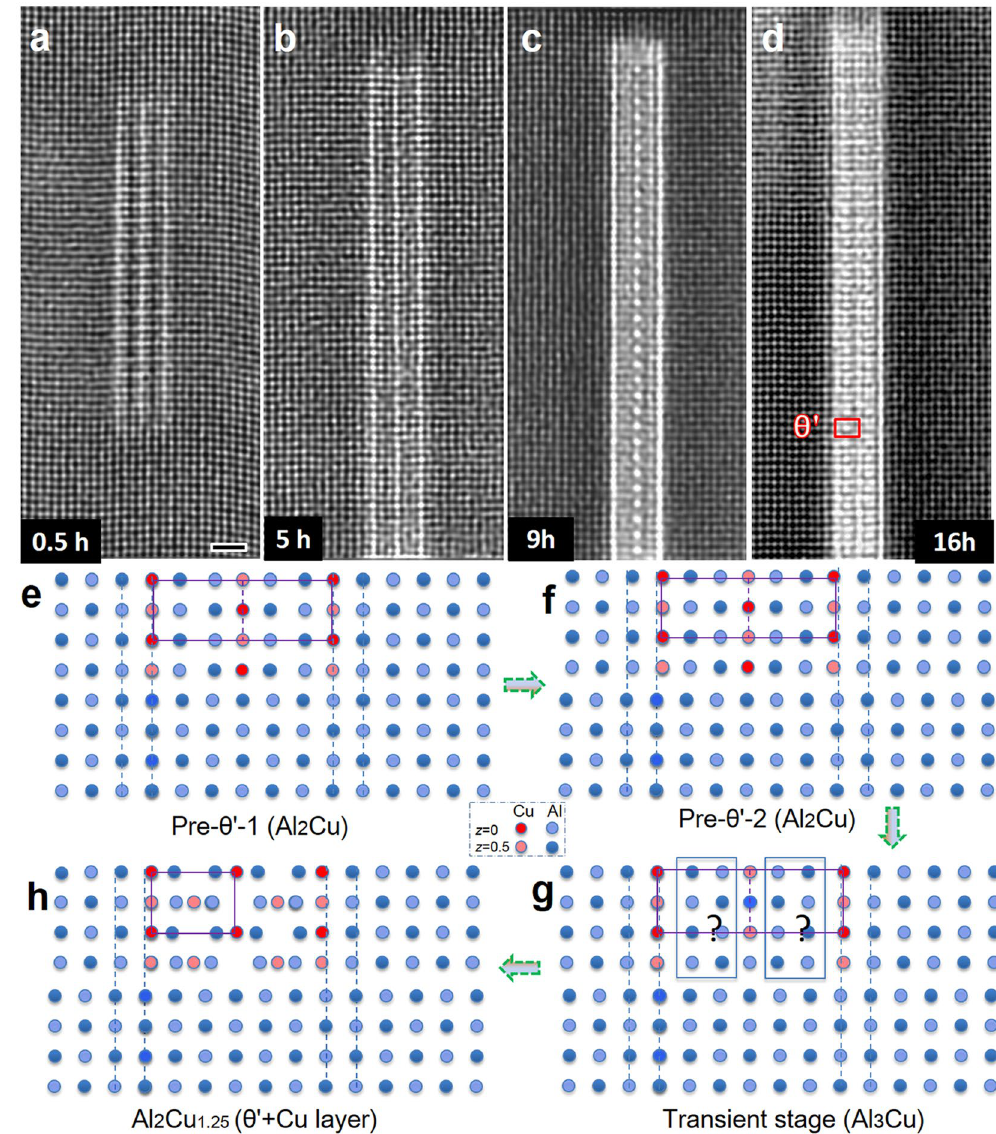
Figure 4. Atomic structure evolution of an individual precipitate. ( a – d ) The HR-STEM images showing the atomic structures of the same precipitate in Al-Cu alloy during ageing at 160 °C for 0.5 h ( a ), 5 h ( b ), 9 h ( c ) and 16 h ( d ). The STEM images are Fourier filtered to reduce the noise. ( e – g ) Structural models of the various phases of the phase transformation occurring inside this precipitate. In order to distinguish the lattice expansion/ contraction in the intermediate stages, dotted lines are shown next to the precipitate and the lattice contraction/ expansion is strongly increased for illustration purposes. Scale bars ( a – d ), 1